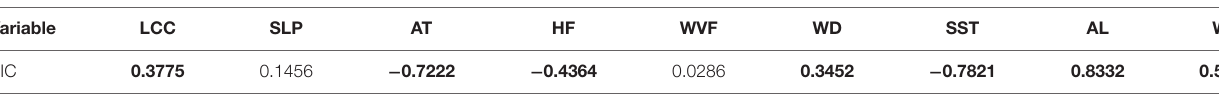
TABLE 1 | KGC index between SIC and predictors (statistically significant values at the 95% level are highlighted). Variable LCC SLP AT HF WVF WD SST AL WV → SIC 0.0068 0 0.4455 0.0061 SIC → 0 0 0.3437 TABLE 2 | Pearson correlation coefficient between SIC and predictors (statistically significant values at the 95% level are highlighted). Variable LCC SLP AT HF WVF WD SST AL WV SIC 0.3775 0.1456 − 0.7222 − 0.4364